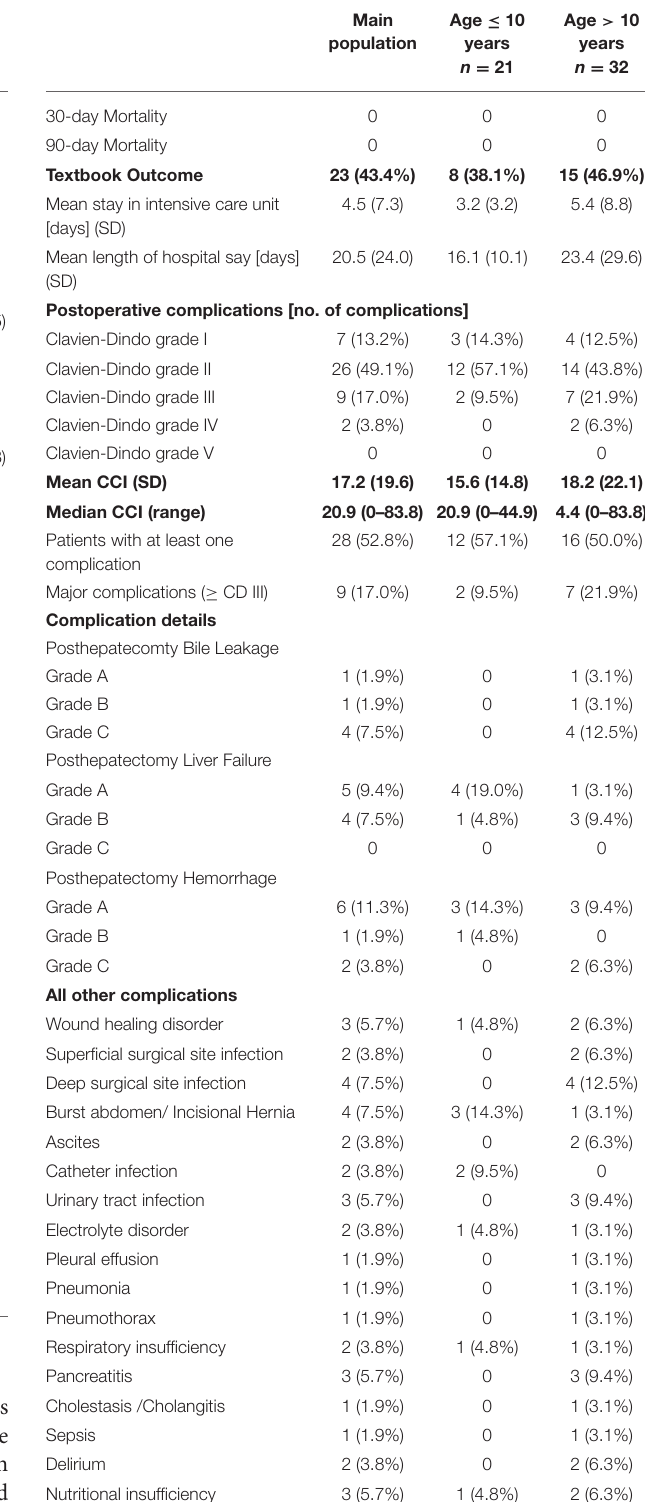
TABLE 2 | Details on surgical procedures. TABLE 3 | Postoperative